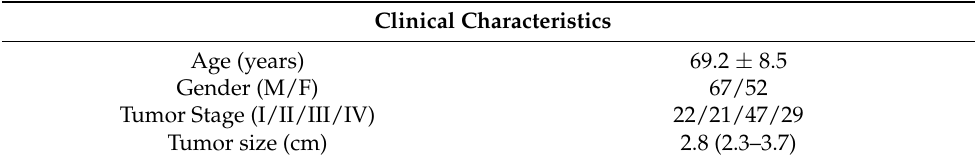
Table 1. Clinical characteristics of the patients in the PDAC cohort. Data are mean ± standard deviation or median (interquartile range). The tumor stages are I—locally resectable; II—borderline resectable; III—locally advanced; IV—metastasized.